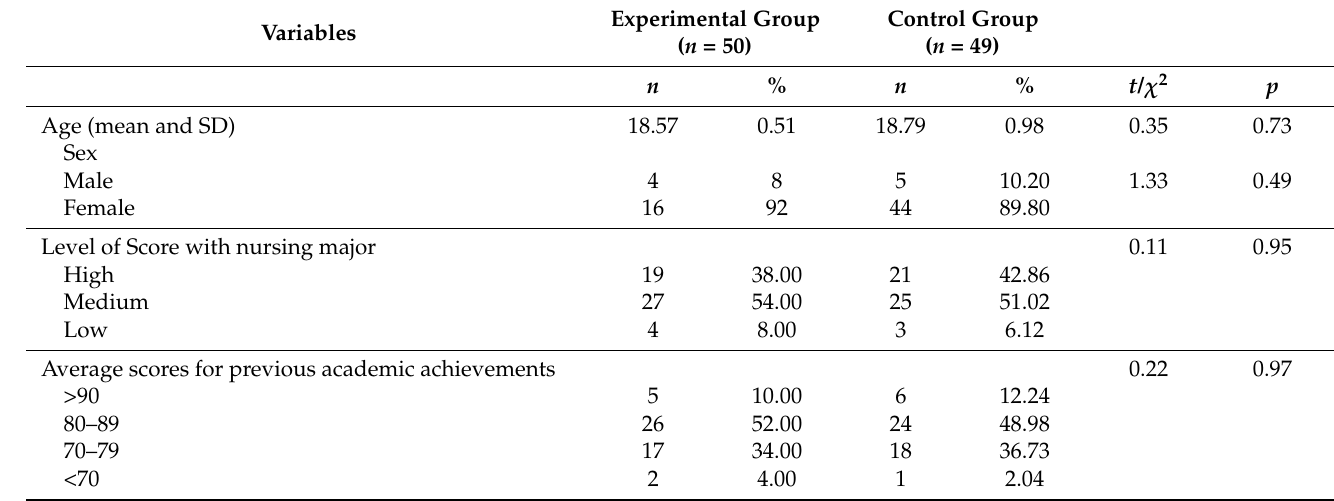
Table 1. Homogeneity test related to personal attributes ( N =